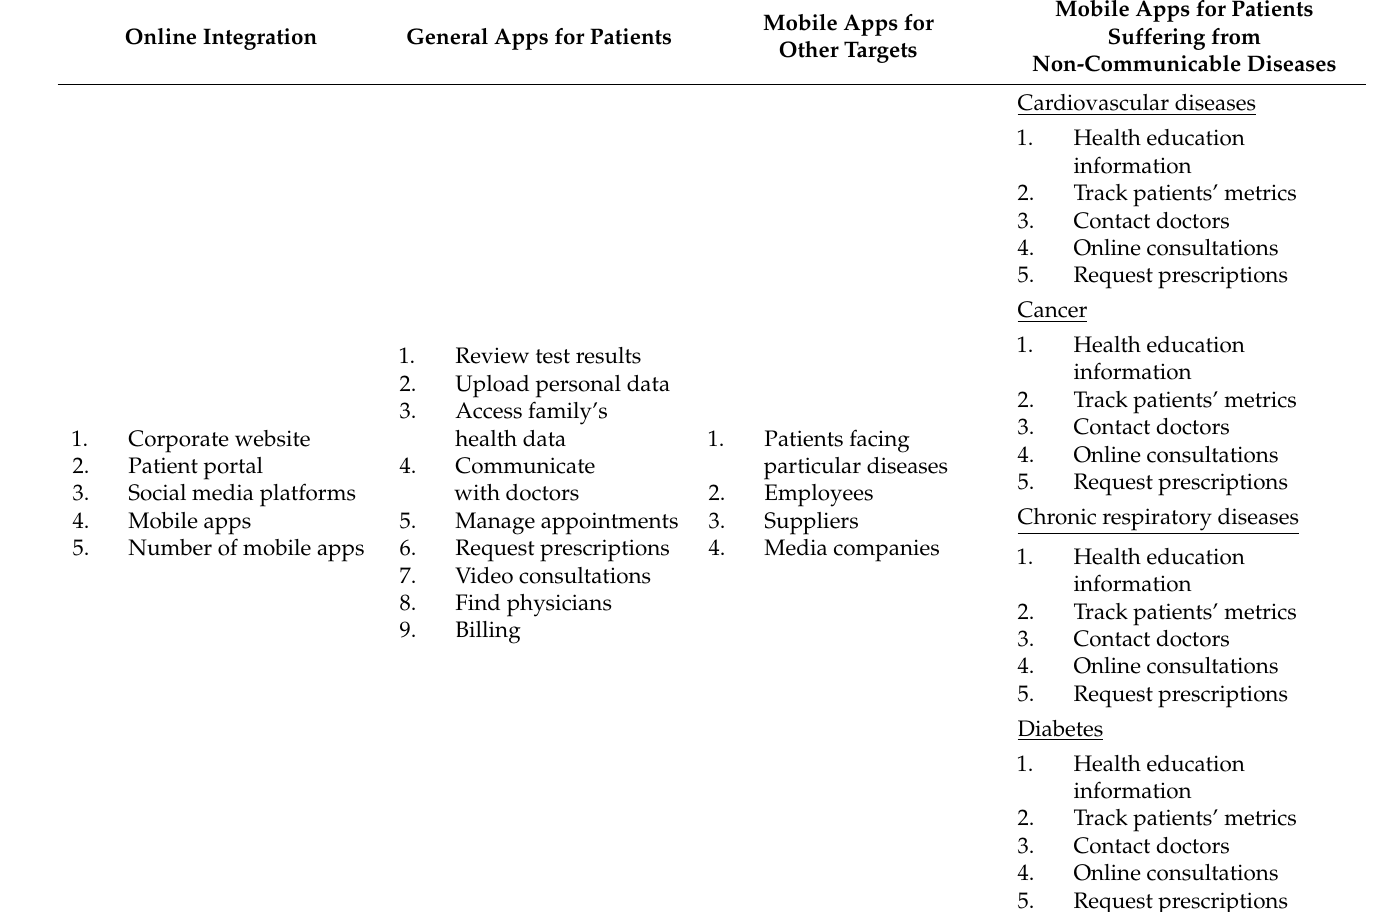
Table 1. Key performance